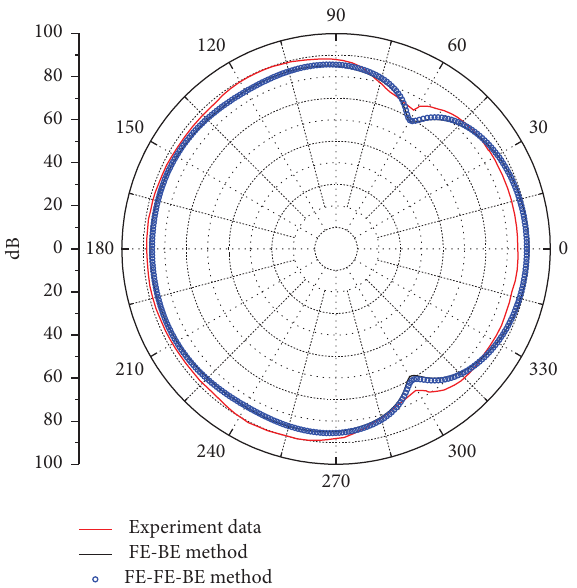
Figure 8: Results of the FE-FE-BE method, FEM-BEM, and